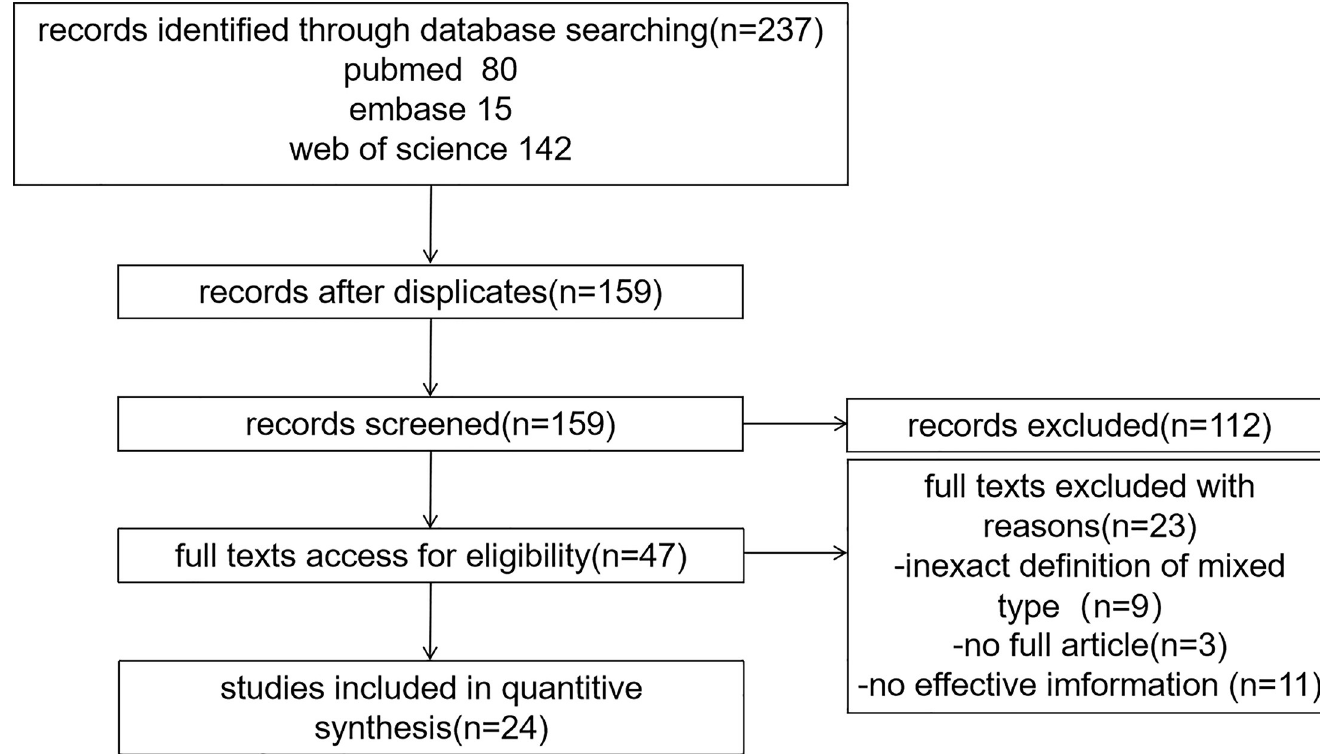
Fig 1. Search results and selection